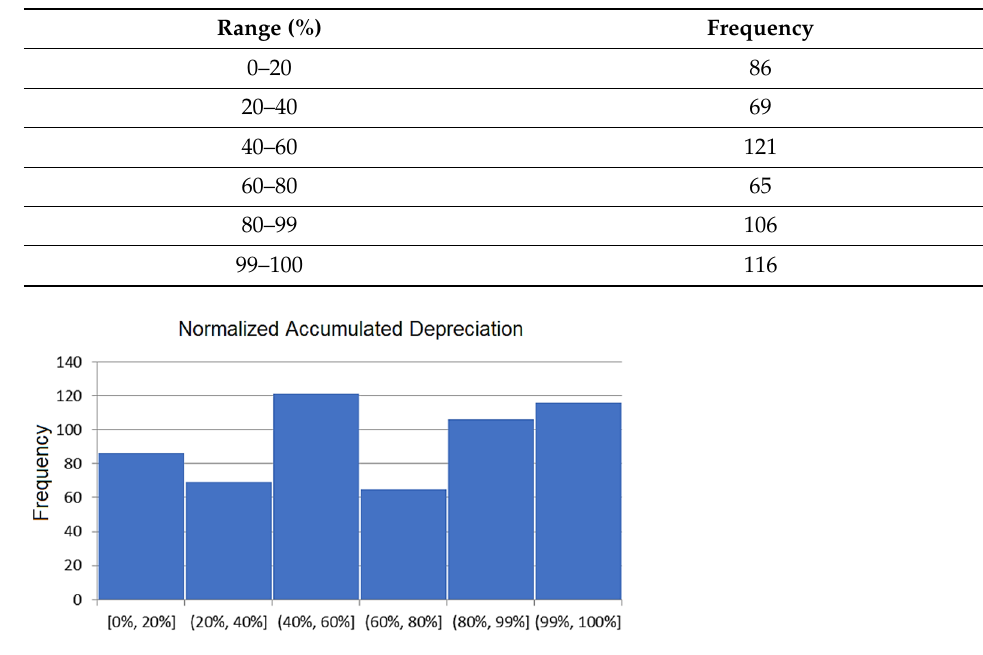
Figure 10. Histogram of accumulated asset depreciation [authors].